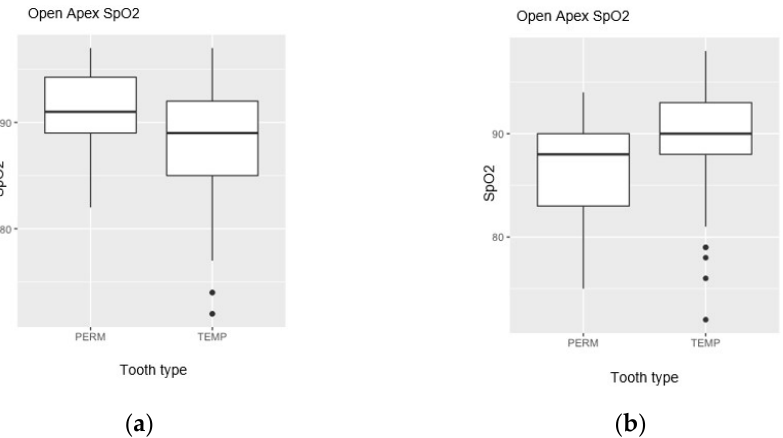
Figure 4. Box plots showing the distributions of SpO 2 values of permanent (PERM) and primary (TEMP) teeth with an open apex ( a ) and with a closed apex ( b ) around the median value (box) and outliers